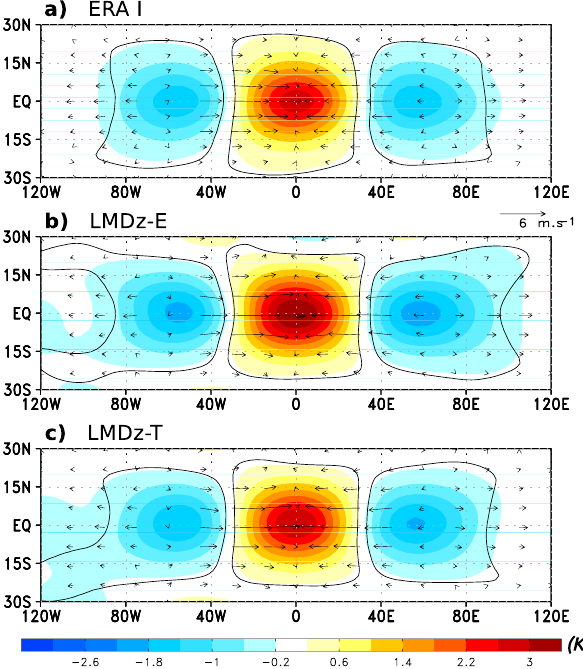
Fig. 6. Longitude–latitude maps for the KW packet composite at the level z p = 50hPa and the l = 0 day lag. The shaded areas are for the temperature T C (red (blue) colours are for positive (nega- tive) values, in K) and the arrows for the horizontal wind (u C ,v C ) : (a) ERAI, (b) LMDz-E, and (c) LMDz-T. The black lines delimit the 99% significant regions according to a Student t test for the temperature.